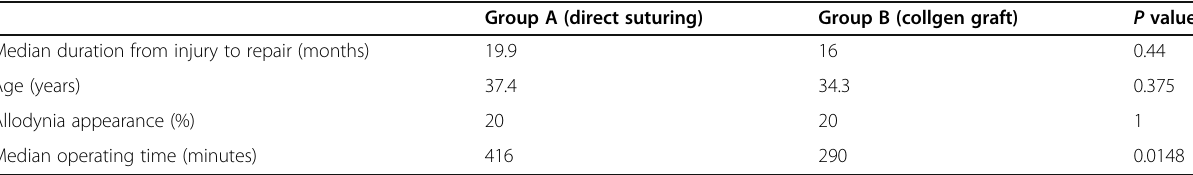
Table 7 Patient characteristics